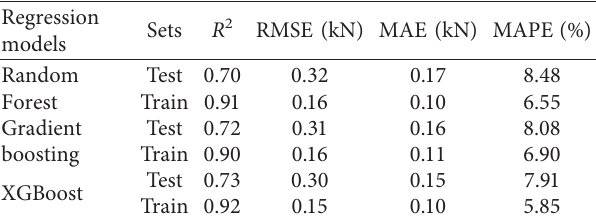
Table 8: Performance measures for the XGBoost, Gradient boosting, and Random Forest